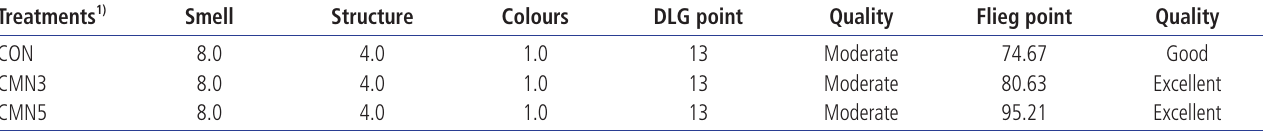
Table 2. The effects of different cumin essential oil levels on silage qualities (n = 3) Treatments 1)